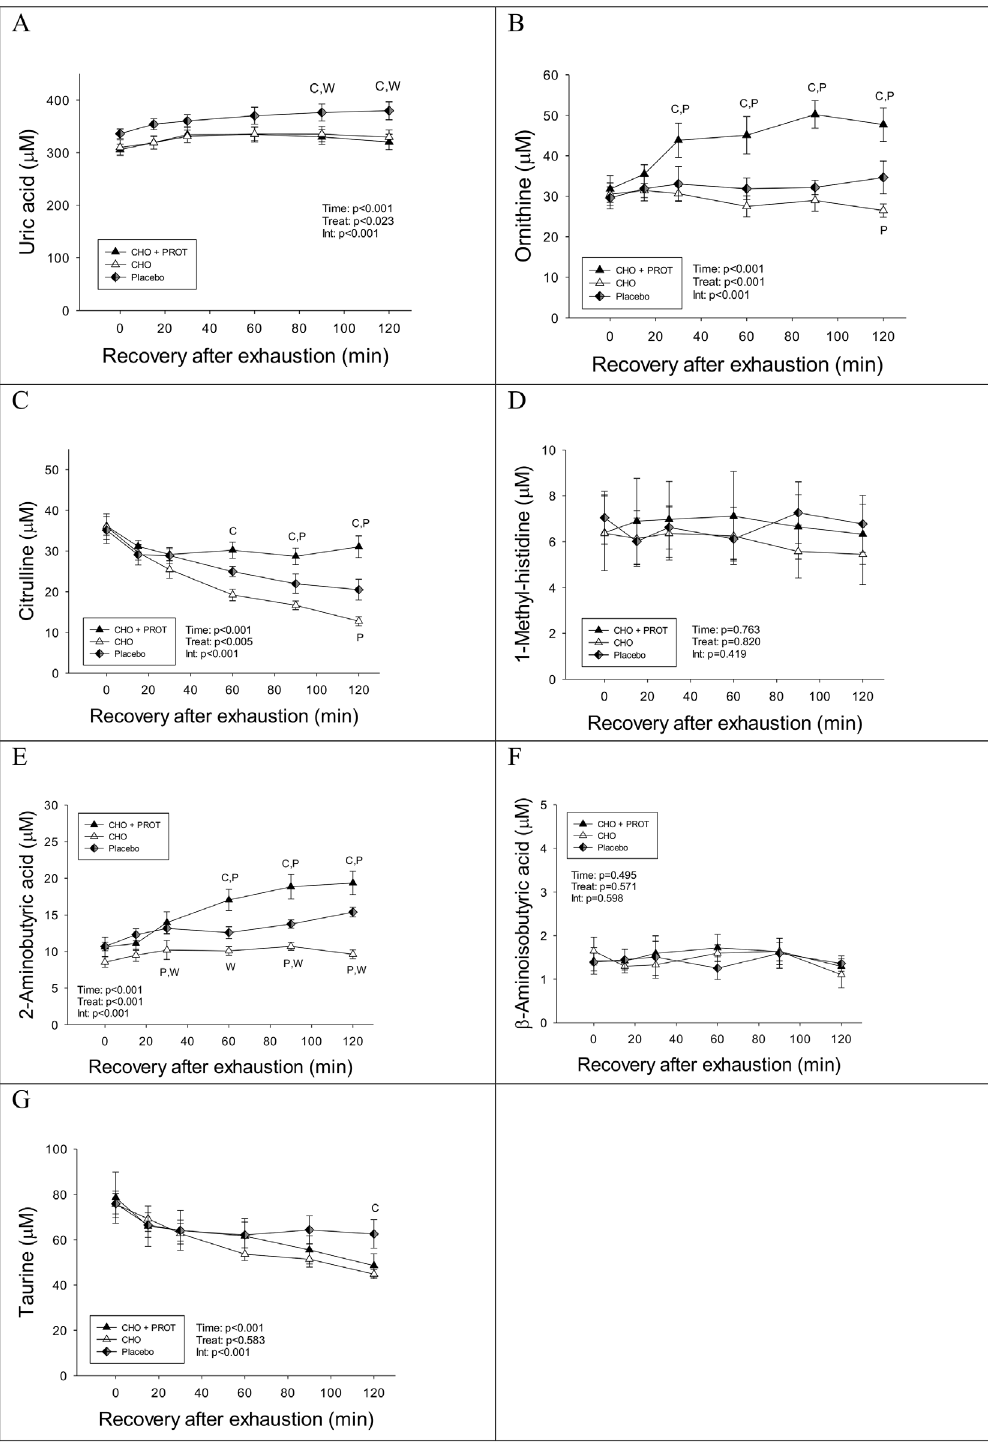
Fig 4. Plasma concentrations of uric acid, ornithine, citrulline and 1-methyl-histidine during the first 2 h of recovery when provided CHO, CHO +PROT or PLA. Data are mean and error bars represents SEM. C: p < 0.05 compared to CHO; W: p < 0.05 compared to CHO+PROT (whey); P: p < 0.05 compared to placebo. N = 8 for all data